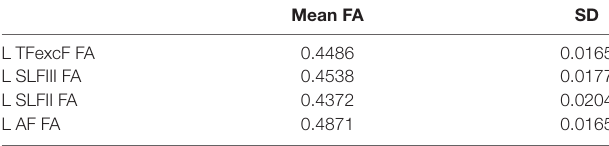
TABLE 3 | Mean FA and standard deviation (SD) of the left (L) hemisphere language tracts in the healthy participants (i.e., the control group). Mean FA SD L TFexcF